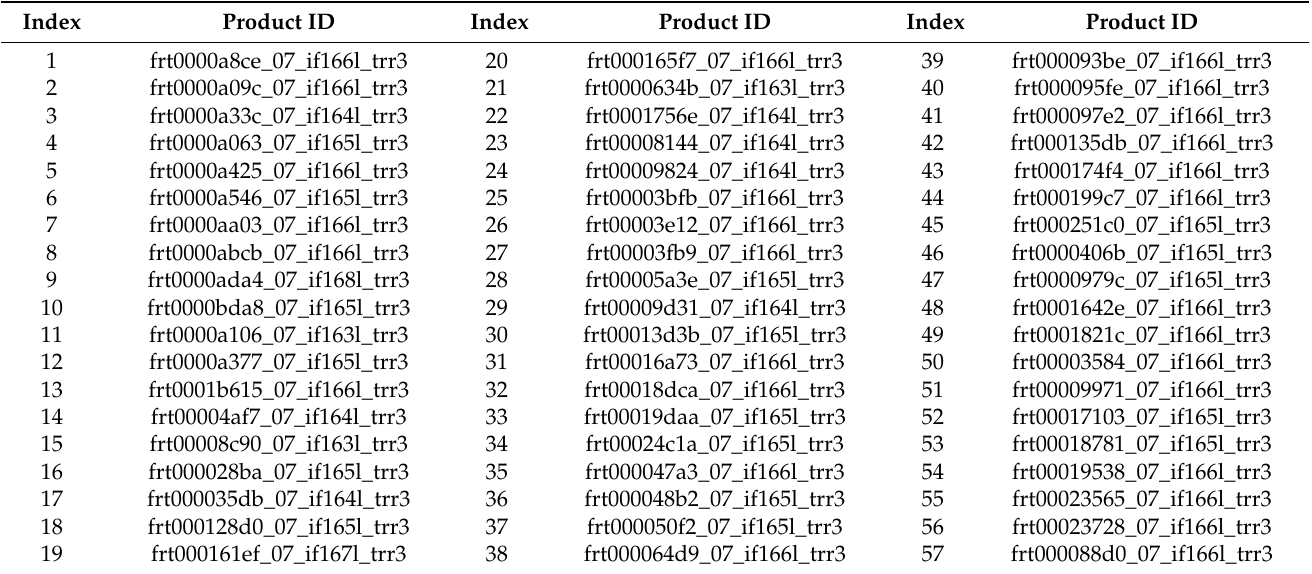
Table A1. Product IDs of the selected CRISM